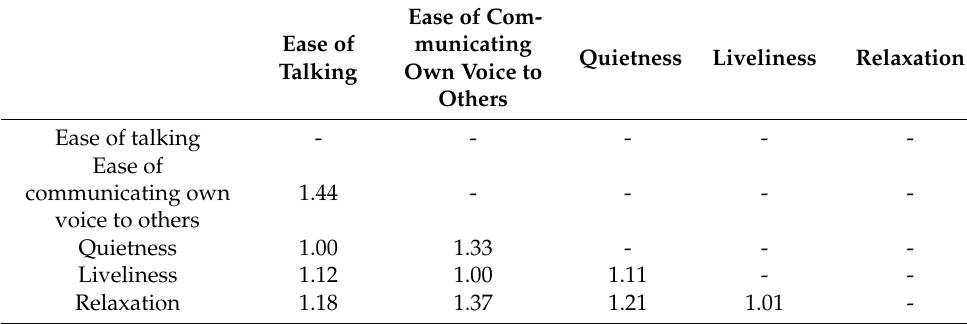
Table 5. Variance inflation factors of the evaluation items in the psychological